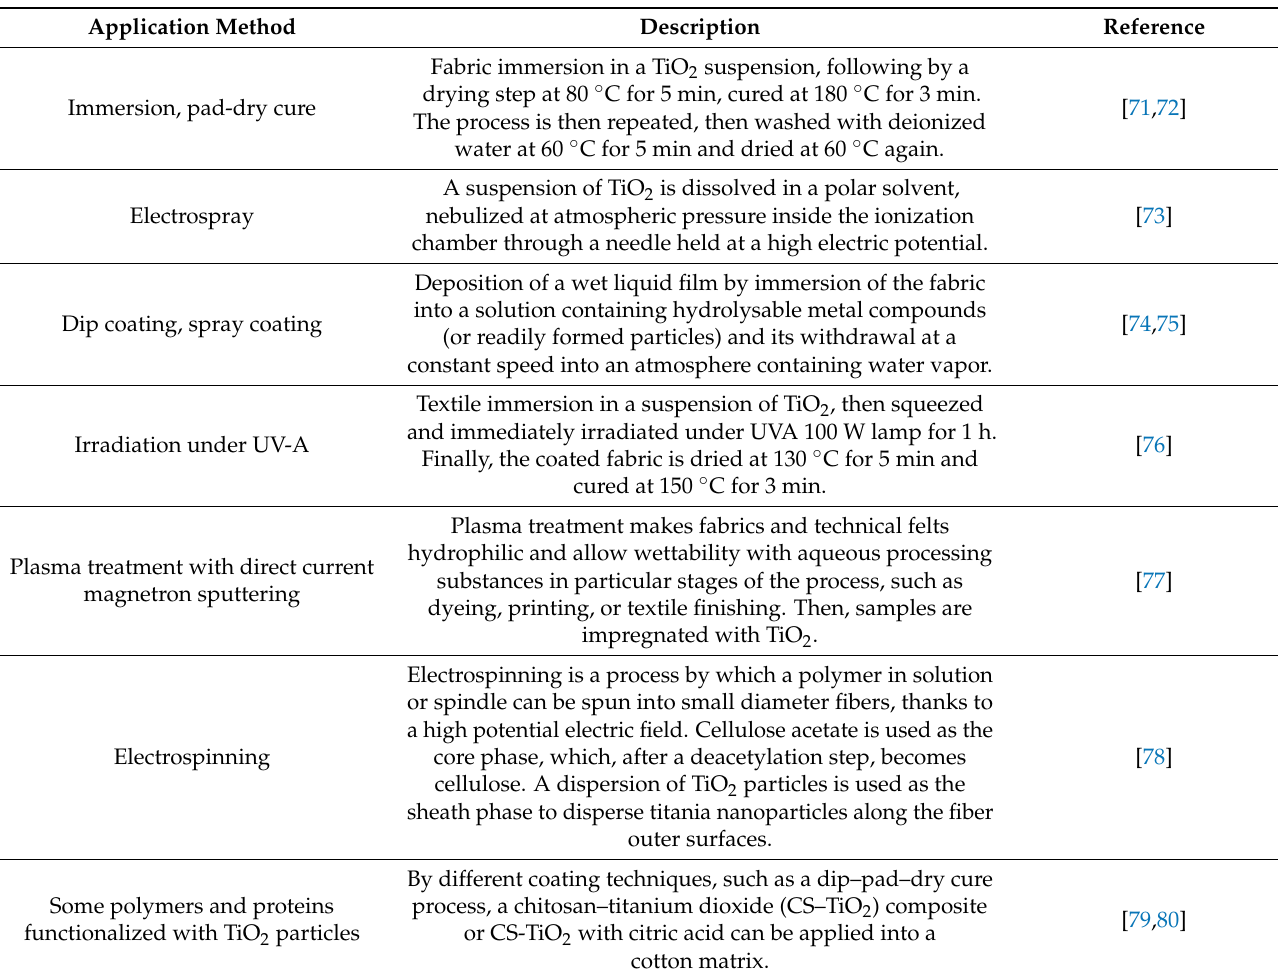
Table 2. Overview of the different (available) methods for TiO 2 coating surfaces from different matrices, including